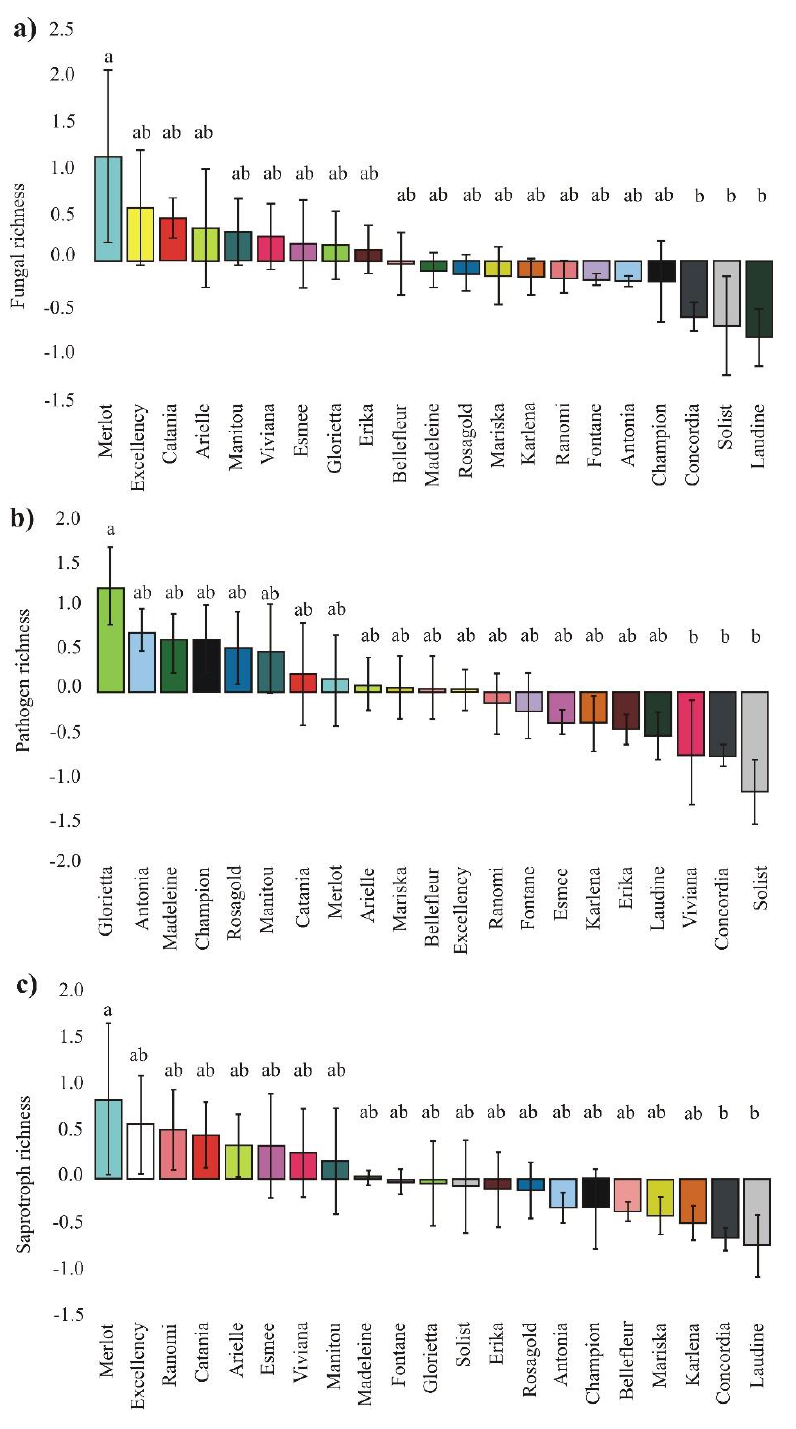
Figure 3. Results of a general linear model estimating the effect of cultivar for root ( a ) overall fungal, ( b ) pathogen, ( c ) saprotroph richness collected across all sampling times and replication blocks. Colours represent the cultivars. Different letters indicate statistically significant differences between cultivars (Tukey HSD post hoc tests, p < 0.05).